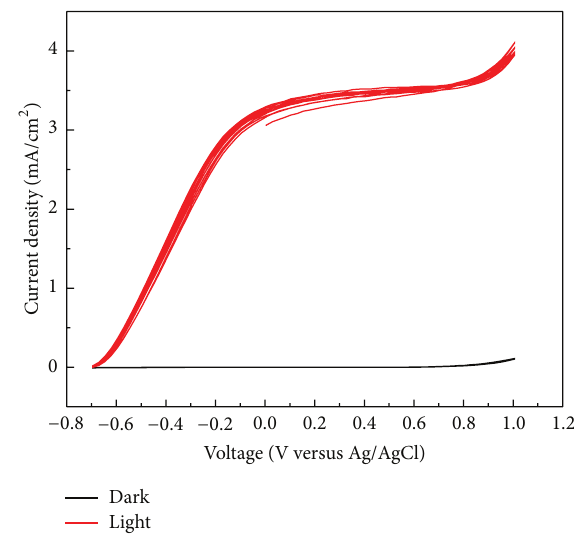
Figure 9: 𝐼𝑉 curves of uncoated CdS in Na 2 SO 3 in dark conditions and under solar radiation, measured at scan rates of 100